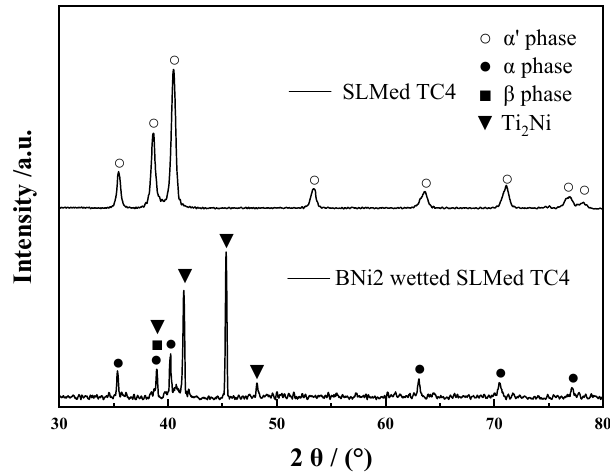
Figure 7. XRD patterns of surfaces of the SLMed TC4 and BNi2 wetted SLMed TC4.